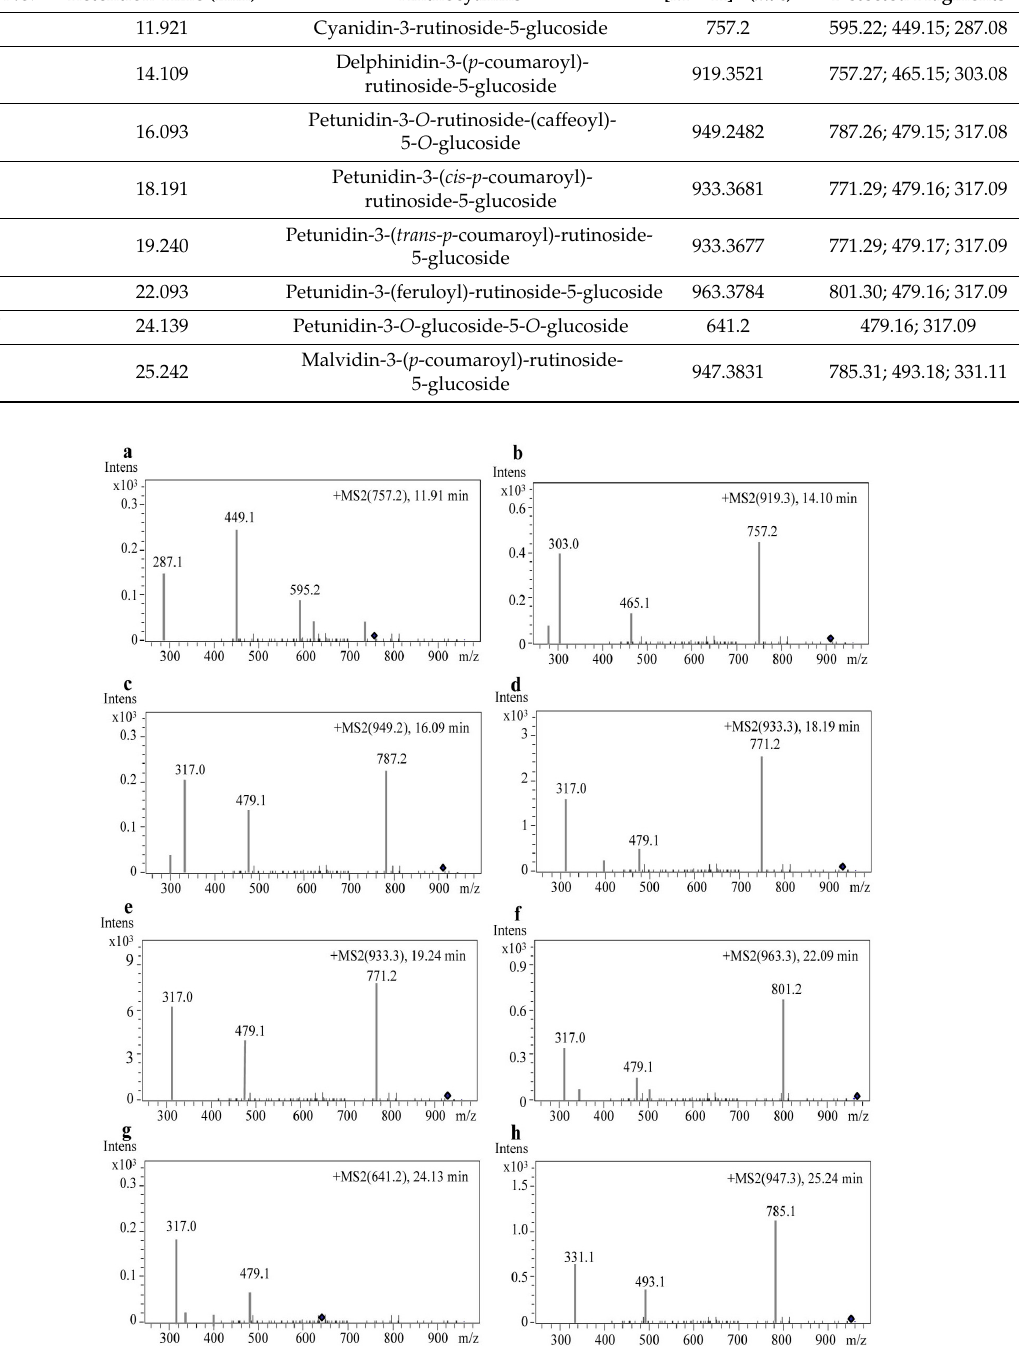
Table 1. Tentative identification of anthocyanin compositions in S. nigrum fruits. Peak No.